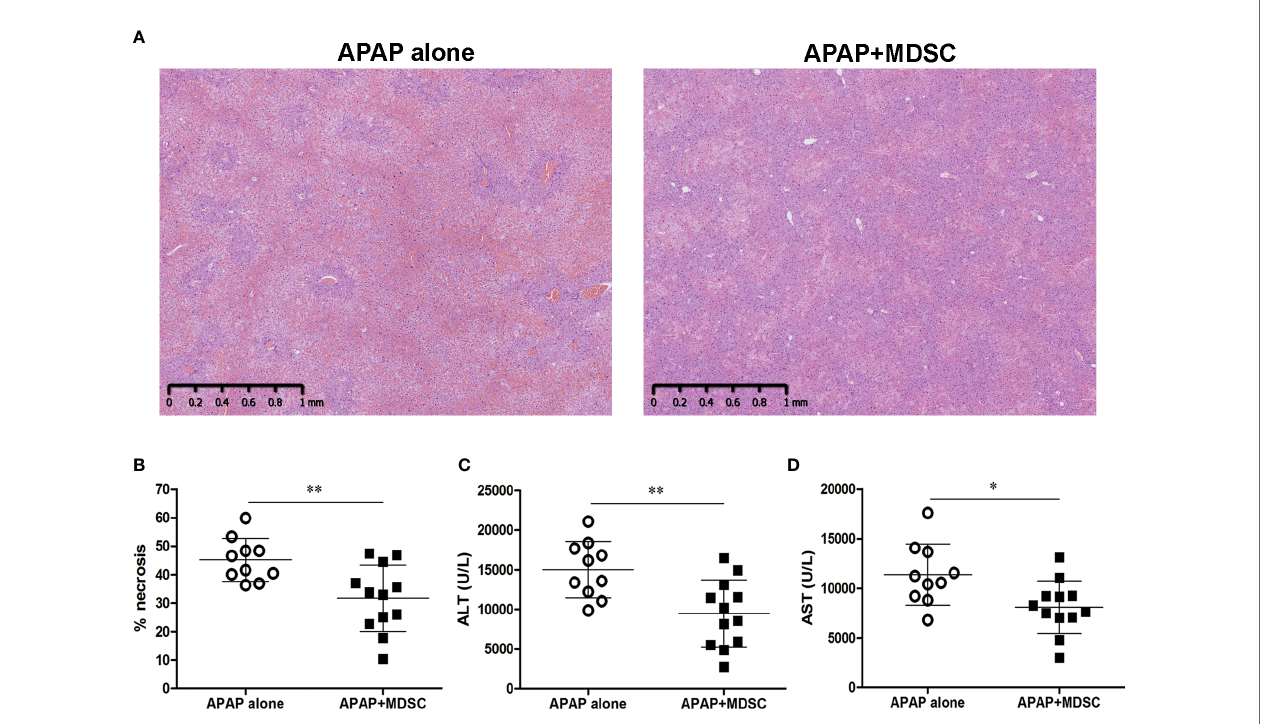
FIGURE 5 | Adpotive transfer of TNF- a /lipopolysaccharide (LPS) myeloid-derived suppressor cells (MDSCs) reduces acetaminophen (APAP)-induced liver injury (A) Liver histological stain of mice injected with APAP alone or combined with adoptive transfer of TNF- a /LPS MDSCs. (B) The quati fi cation of liver necrosis. (C) Serum ALT levels and (D) Serum AST levels at 12 h after APAP challenge (n=10-12). *P < 0.05, **P < 0.01, Mann-Whitney test. Data were expressed as mean ±